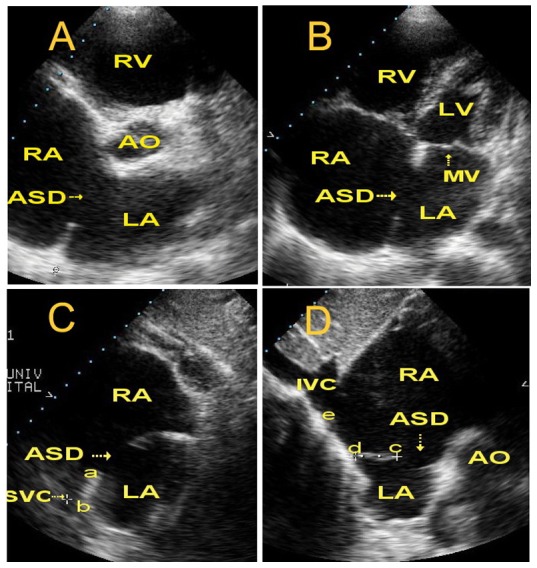
Measurement of ASD diameter and surrounding rims using TTE in different cross sections in a patient with ASD and a deficient superior-anterior rim.(A) Parasternal short-axis view showing measurement of the ASD diameter and the length of superior-posterior rim. The superior-anterior rim was absent. (B) Apical four chamber view showing measurement of the ASD diameter and the rim length from ASD to the mitral annulus and to the top of the atrium. (C and D) Subcostal view showing measurement of the ASD diameter, total atrial septal length, and rim length from the ASD to the mitral annulus and the superior vena cava (SVC) and inferior vena cava (IVC) entrances. Distance from “a” to “b” is the rim length of the SVC side, “c” to “d” rather than “c” to “e” is the rim length of the IVC side. The distance from “d” to “e” is the posteroinferior wall of the right atrium. ASD = atrial septal defect, AO = ascending aorta, LA = left atrium, RA = right atrium, LV = left ventricle, RV = right ventricle, IVC = inferior vena cava, SVC = superior vena cava.